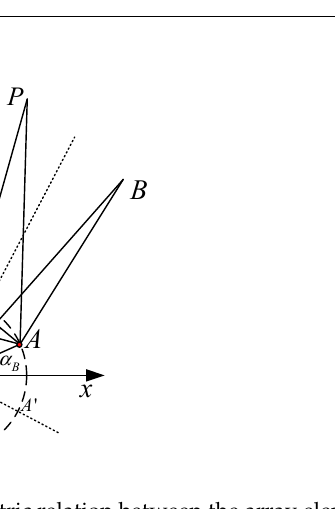
Figure 2. Geometric relation between the array elements, with position error and radiant source. Obviously, when the actual position of the array element is on the circle, the phase error is larger than when it is in the circle. Point A is set as a moving point on the circle to represent the actual position of the n th array element. When the two sources, P ( x P , y P ) and B ( x B , y B ) , have relative phase errors | ∆ ϕ BP | ≤ π , it is considered that the compensation is effective [27,28]. There is